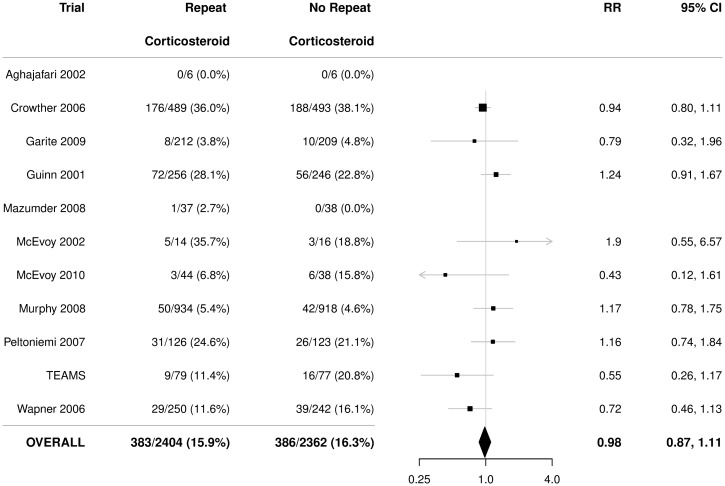
Primary outcomes for the women: Maternal sepsis.Maternal sepsis defined as one of the following: chorioamnionitis during labour, pyrexia after trial entry requiring the use of antibiotics, puerperal sepsis, intrapartum fever requiring the use of antibiotics, or postnatal pyrexia. Figures are numbers (percentages) with RR and 95% CI. p-value for heterogeneity 0.22. CI, confidence interval; RR, relative risk; TEAMS, Trial of the Effects of Antenatal Multiple courses of Steroids versus a single course.